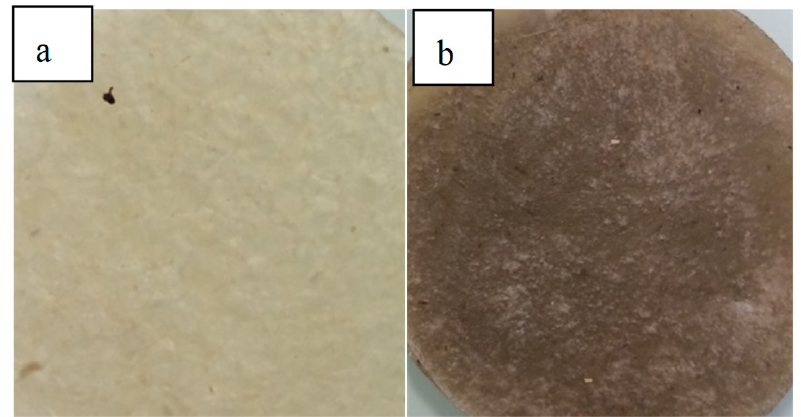
Figure 5. Visual appearance of the plasticized starch (TPS) obtained by RMX: ( a ) 145 °C, ( b ) 160 °C.